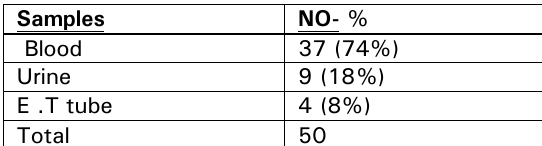
Table 1: Distribution of samples showing growth of candida species Samples